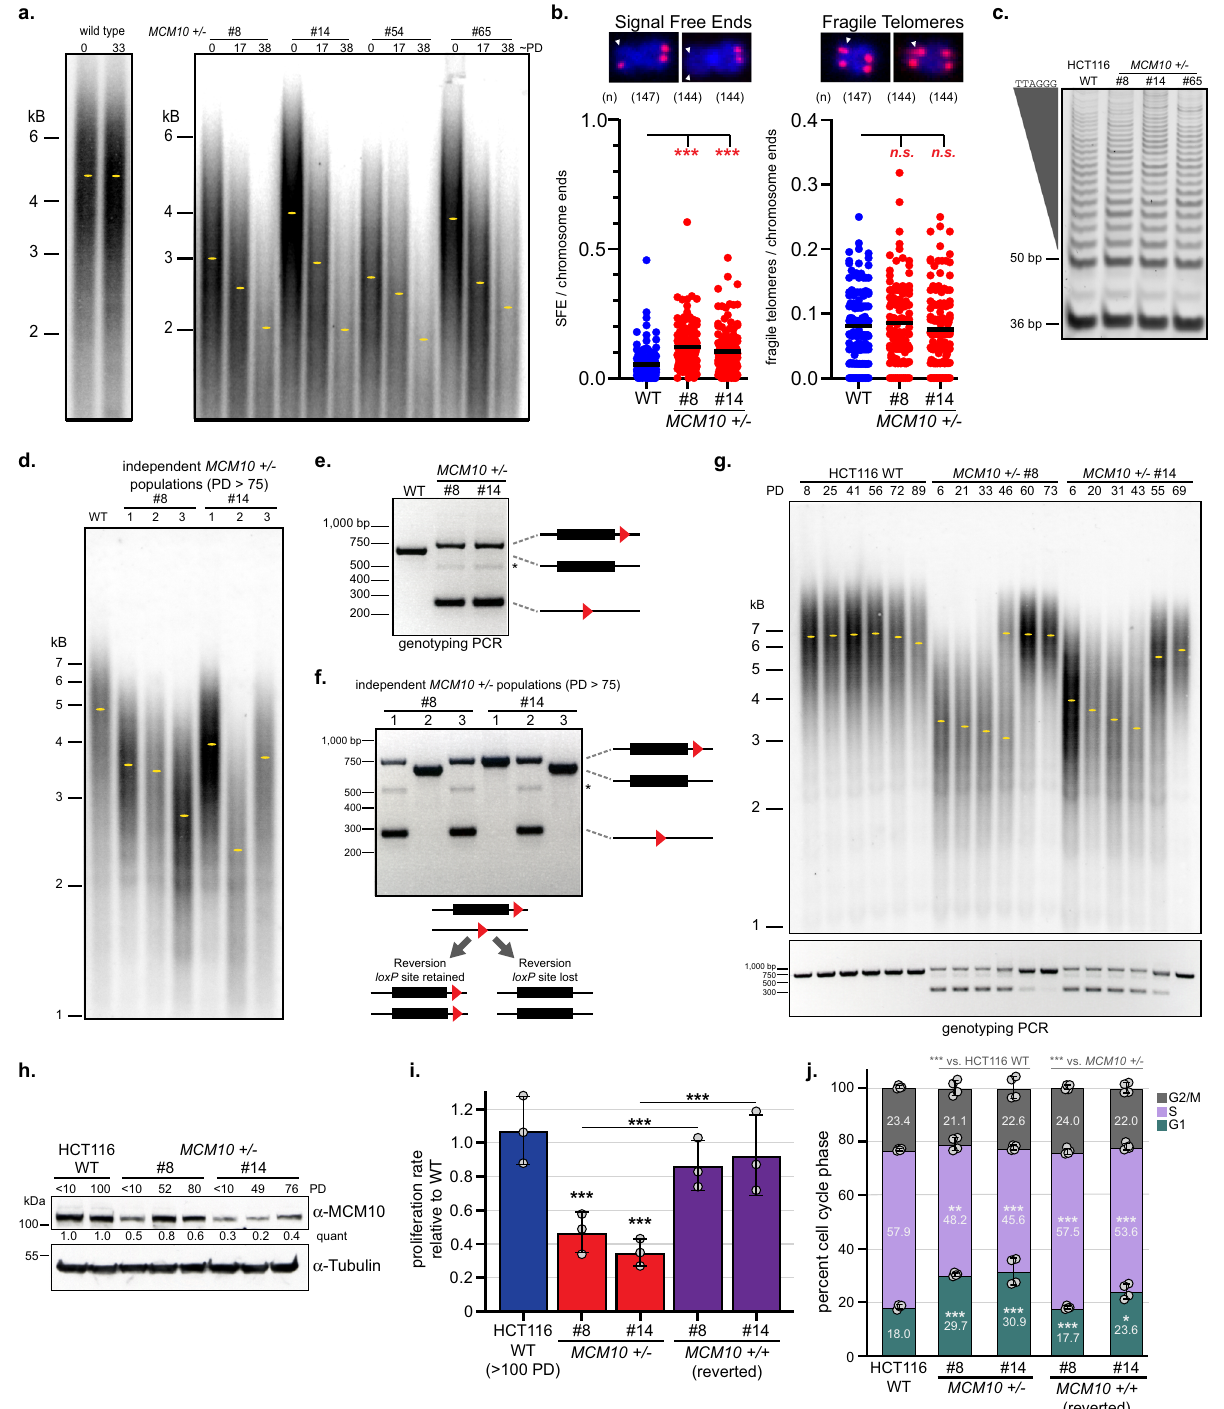
haploinsuf fi ciency might be unique to human cell lines.